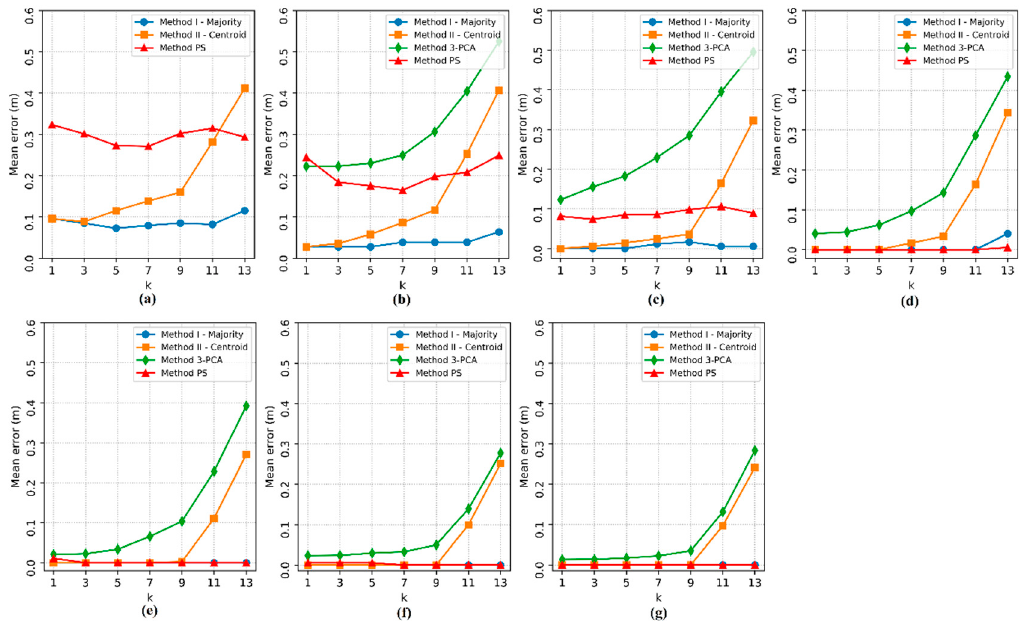
Figure 8. Localization mean error varying the number of access points (n) and the hyperparameter k. The subfigures show the tests for each number of access points: ( a ) 2 APs, ( b ) 3 APs, ( c ) 4 APs, ( d ) 5 APs, ( e ) 6 APs, ( f ) 7 APs and ( g ) 8 APs.